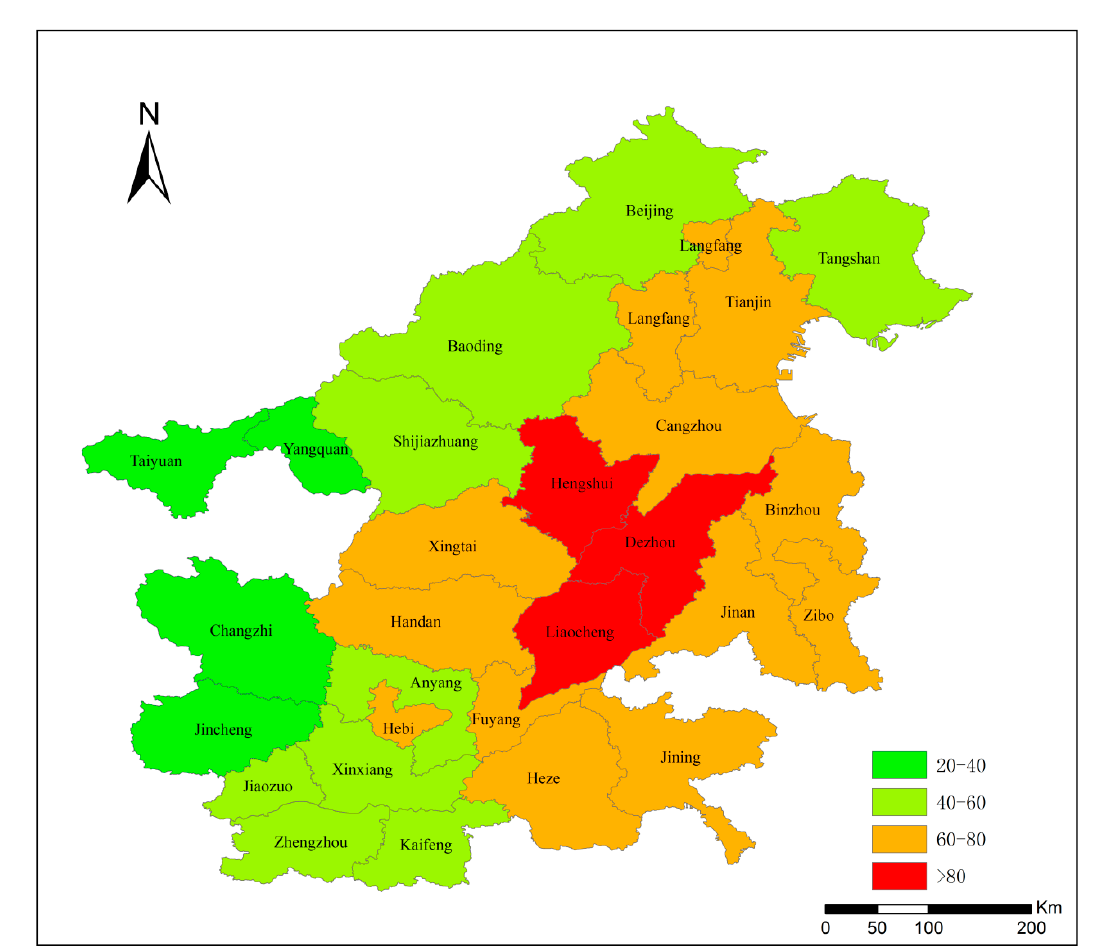
Figure 2. Average PM 2.5 concentration of ‘2 + 26’ cities in 2020 ( μ g/m 3 ). (Data source: China Environmental Monitoring Station, 2020).